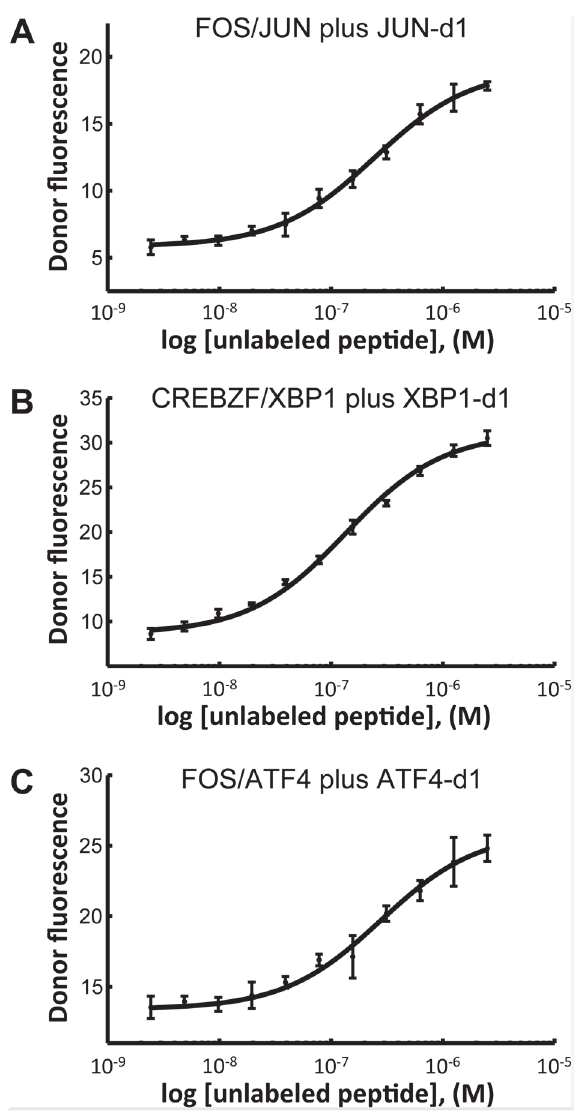
Fig 4. Designed bZIP-binding peptides inhibit interactions of native bZIP dimers. (A) JUN-d1 inhibits the interaction of 10 nM JUN with 50 nM FOS with an IC 50 of 245 nM at 37°C. (B) XBP1-d1 inhibits the interaction of 10 nM XBP1 with 50 nM CREBZF with an IC 50 of 136 nM at 23°C. (C) ATF4-d1 inhibits the interaction of 10 nM ATF4 with 200 nM FOS with an IC 50 of 279 nM at 37°C. The dissociation constants at the indicated temperatures are K d (cid:3) 1 nM for FOS-JUN, K d (cid:3) 1 nM for XBP1-CREBZF, and K d = 60 nM for ATF4- FOS, according to [18]. Fluorescence intensities were measured at both 37°C and 23°C, and the IC 50 value was fit and reported for the highest temperature that gave a well-defined lower baseline. The target bZIP in each complex was labeled with the FRET donor (fluorescein), the partner was labeled with the TAMRA FRET acceptor, and the design was unlabeled. Fluorescence emission was monitored at 525 nm and is reported in relative fluorescence units.